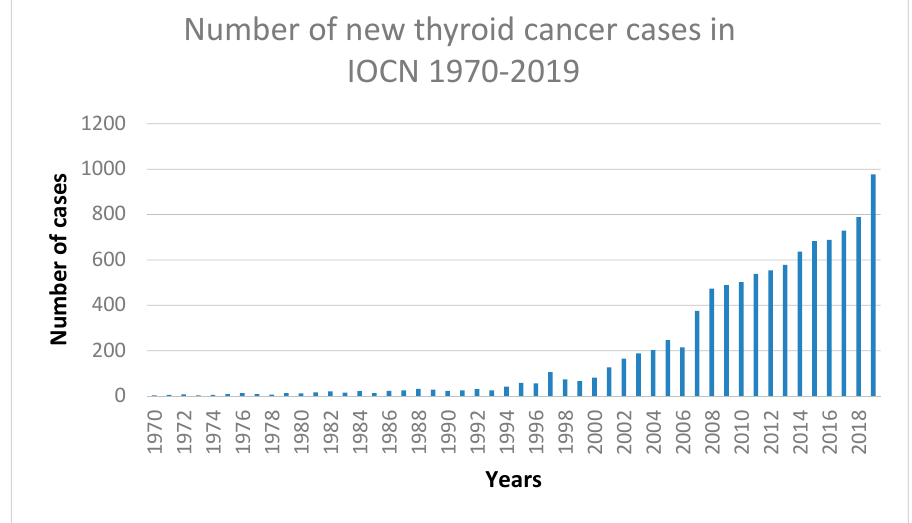
Figure 8. Graphical representation of thyroid cancer cases between 1970 and 2019 in the “Prof. Dr. Ion Chiricu ț a” Institute of Oncology (IOCN), Cluj-Napoca, Romania.